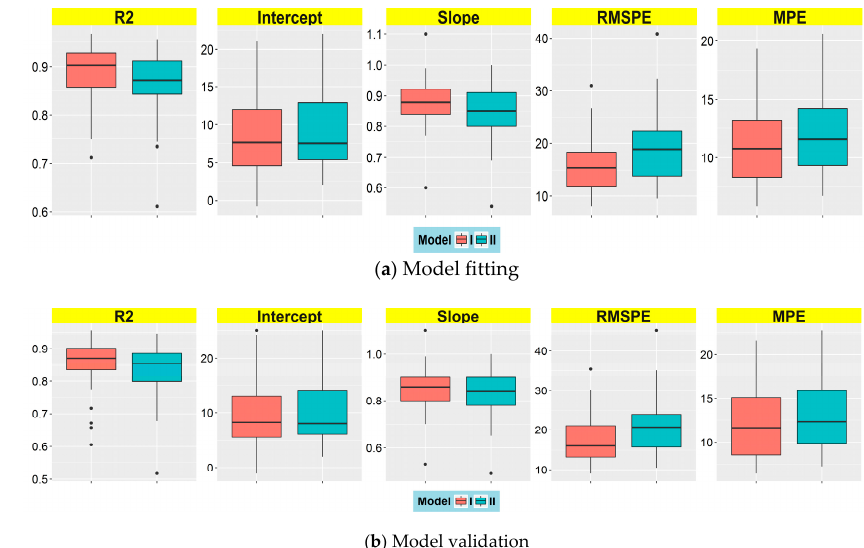
Figure 4. Boxplot statistics of the PM 2.5 estimation performance at each site in terms of R 2 , Intercept, Slope, RMSPE ( μ g/m 3 ), MPE ( μ g/m 3 ) for 3 km MOD-3K AOT: ( a ) Model fitting; ( b ) Model validation. ‘I’ denotes models using the PM 2.5 24 h average, and ‘II’ denotes models using the PM 2.5 period average.